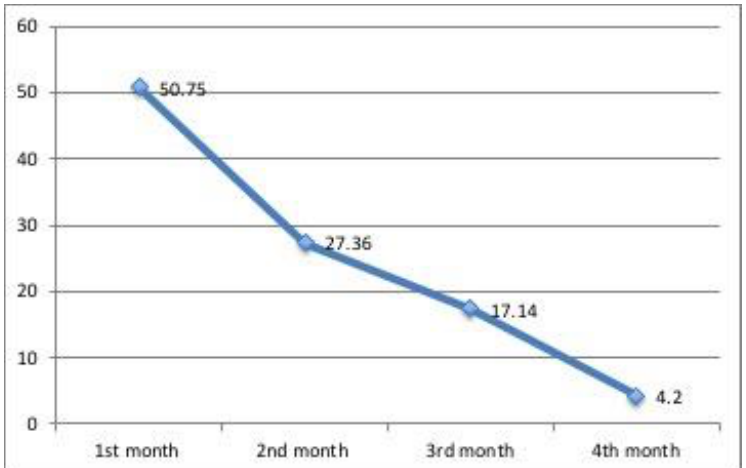
Figure 3 . Time analysis of discussion board participation (percentage of messages posted on the